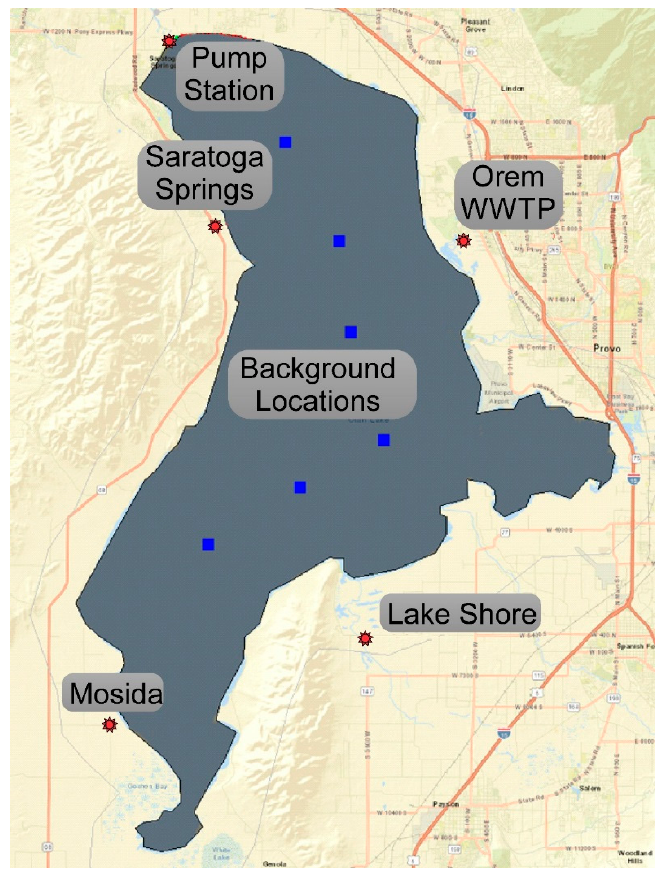
Figure 3. Utah Lake coverage showing the eleven points used in interpolation.